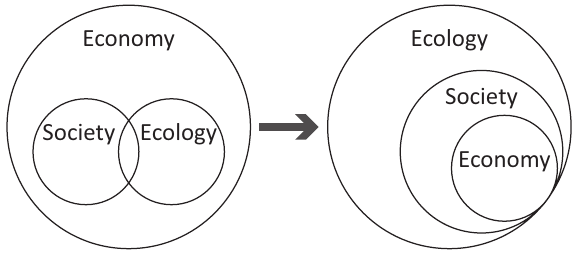
Figure 1. Sustainabilty as a transition from the mod- ernist paradigm grounded in economics towards ecolog- ical